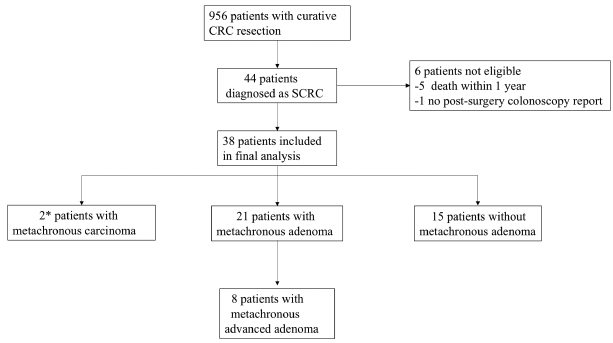
Figure 1. Flowchart of included patients. *1 patient detected MC at 9 months after surgery; 1 patient detected MC at 17 months after surgery. CRC, colorectal cancer; SCRC, synchronous colorectal cancer; MC, metachronous carcinoma.